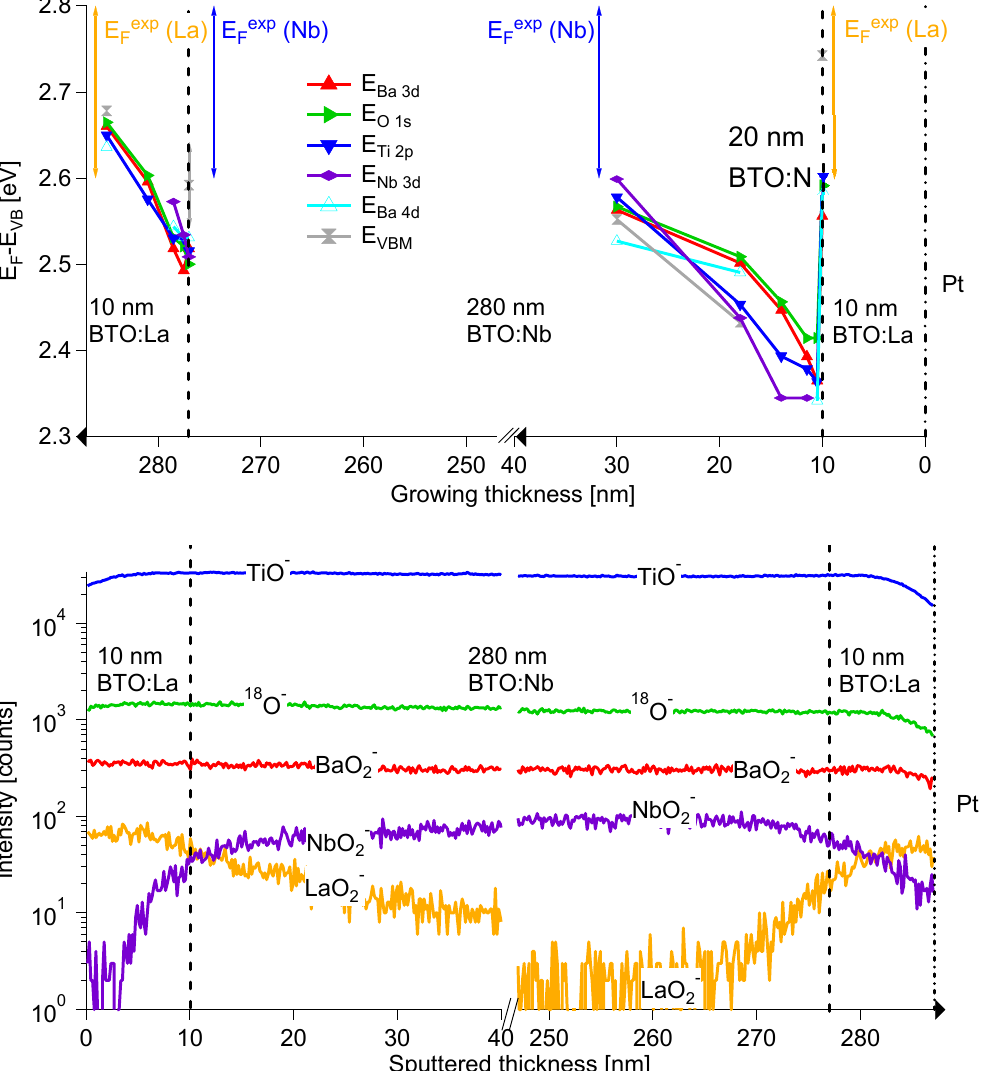
Figure 7. Top. In situ XPS stepwise interface experiments of 8 nm thick BTO:La layer on a BTO:Nb layer (left) and a 20-nm-thick BTO:Nb layer on a BTO:La substrate (right). First points (starting from dashed lines) correspond to a single doped layer. For reference, the range of Fermi level positions with respect to the valence band of single doped films obtained by XPS in situ is plotted. As E CL -E VBM is a material constant, the values of core level positions of each element were obtained by subtracting: 776.57 eV for Ba3d, 527.09 eV for O1s, 455.79 eV for Ti2p, 204.40 eV for Nb3d and 86.07 eV for Ba4d (values obtained by averaging over 100 samples). Error on these values is ± 0.05 eV. Bottom. Time-of-flight secondary ion mass spectroscopy (TOF-SIMS) depth profiling of sample LNL10. Analyzed ion species are written over their corresponding lines.